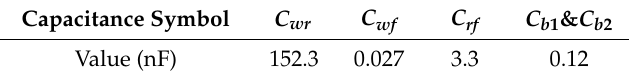
Figure 3. Proposed active common-mode voltage canceler connected between the rotor winding and AC–DC converter of DFIG.